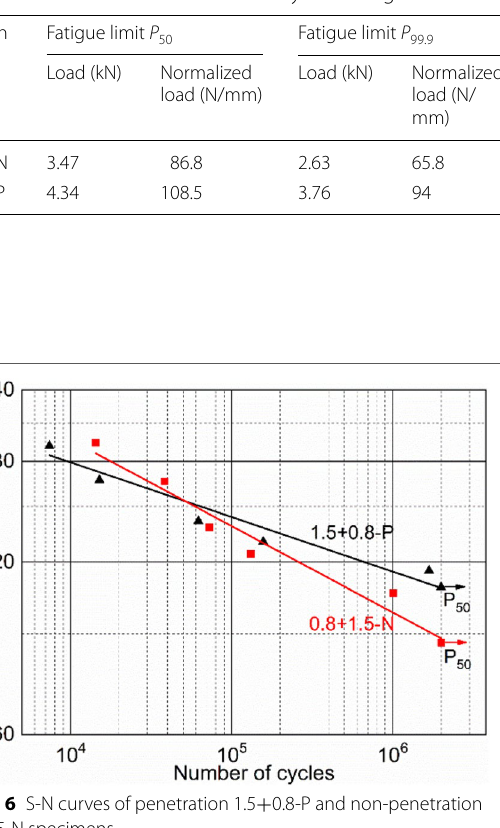
0.8-P and non-penetration +